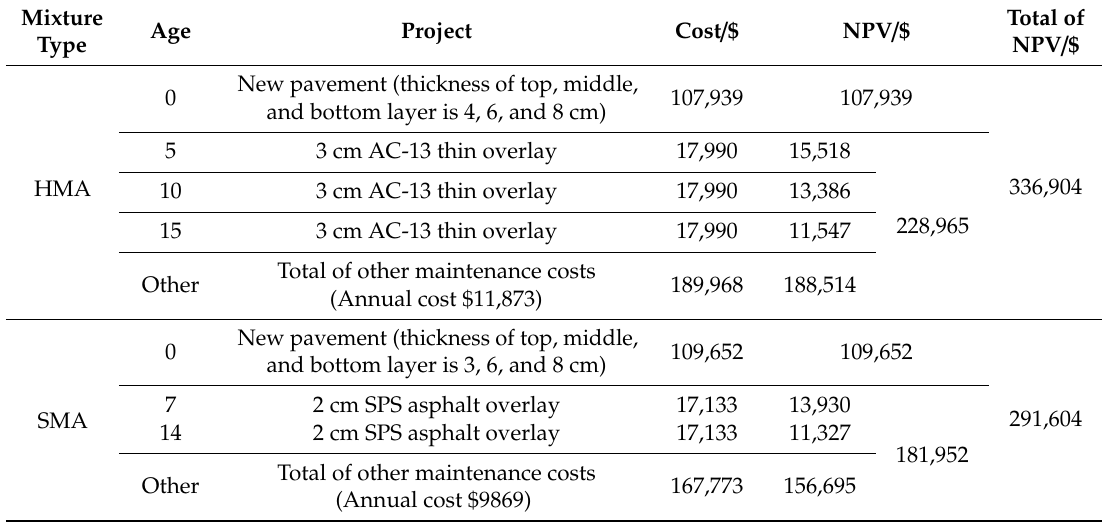
Table 21. Life-cycle cost analysis of HMA and SMA pavements with SPS asphalt overlay.